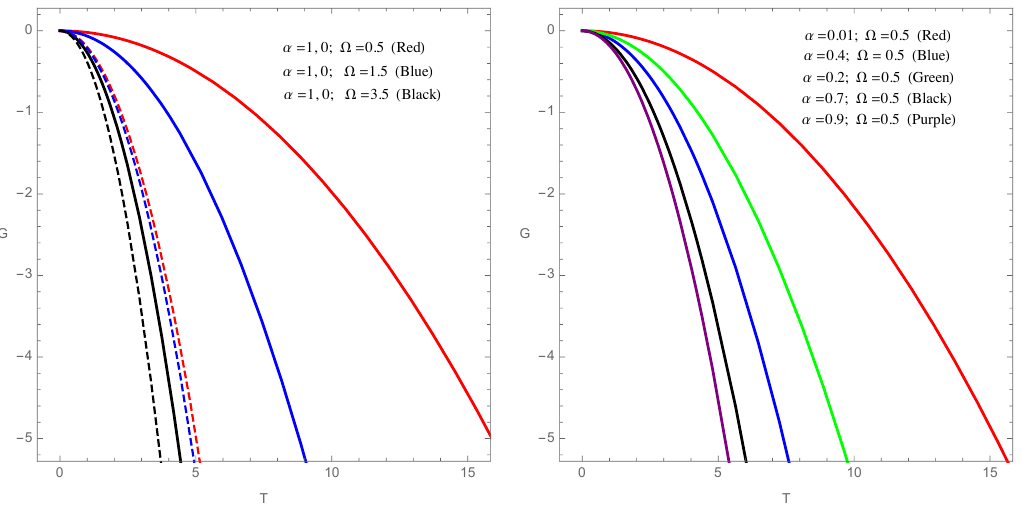
Figure 10 . Gibbs free energy for the grand-canonical ensemble : Left panel: Pure exotic (continuous lines) and standard case (dashed lines) for several values of (cid:10). Right panel: di(cid:11)erent (cid:11) ’s and respective (cid:13) = 1 (cid:0) (cid:11)